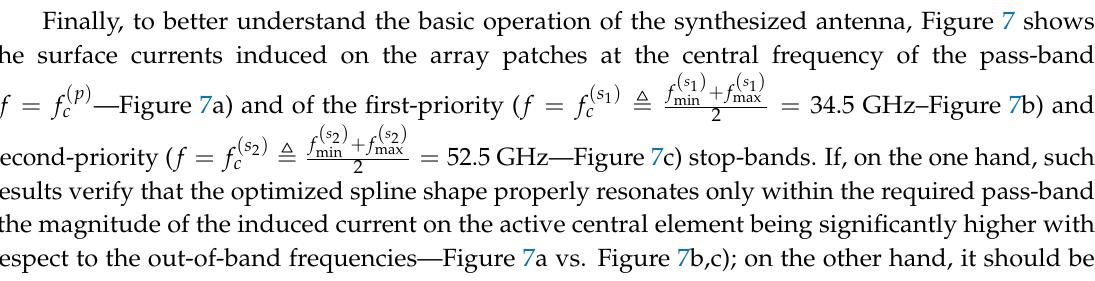
Figure 6. Single embedded element assessment ( inter-element scattering